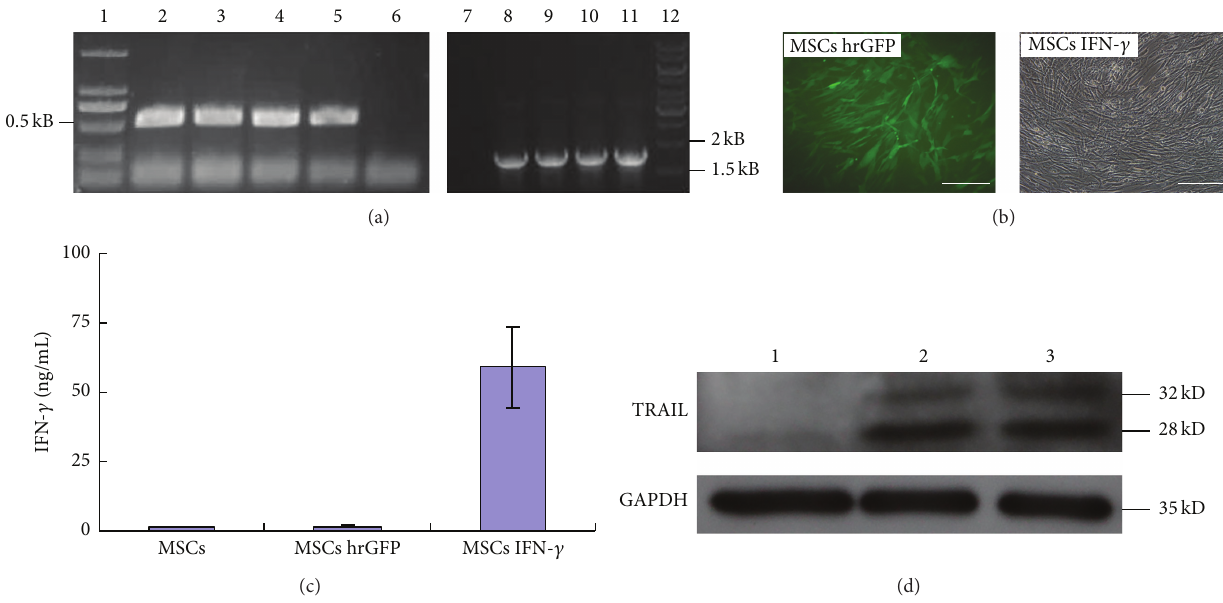
Figure 2: Construction of IFN- 𝛾 -modified MSCs. (a) The lentiviral vector pLV/Final-puro-EF1 𝛼 - IFN- 𝛾 was identified by PCR. Lane 6/7: negative controls; lanes 2–5: amplification fragments of the IFN- 𝛾 coding sequence; lanes 8–11: amplification fragments of the EF1 𝛼 promoter sequence. (b) The morphology of MSCs hrGFP and MSCs IFN- 𝛾 . Scale bar: 200 𝜇 m. (c) The expression of IFN- 𝛾 was assayed by ELISA. (d) TRAIL expression in MSCs IFN- 𝛾 was determined by Western blotting analysis. Lane 1: negative control; lane 2/3: MSCs IFN- 𝛾 at P2 and P5